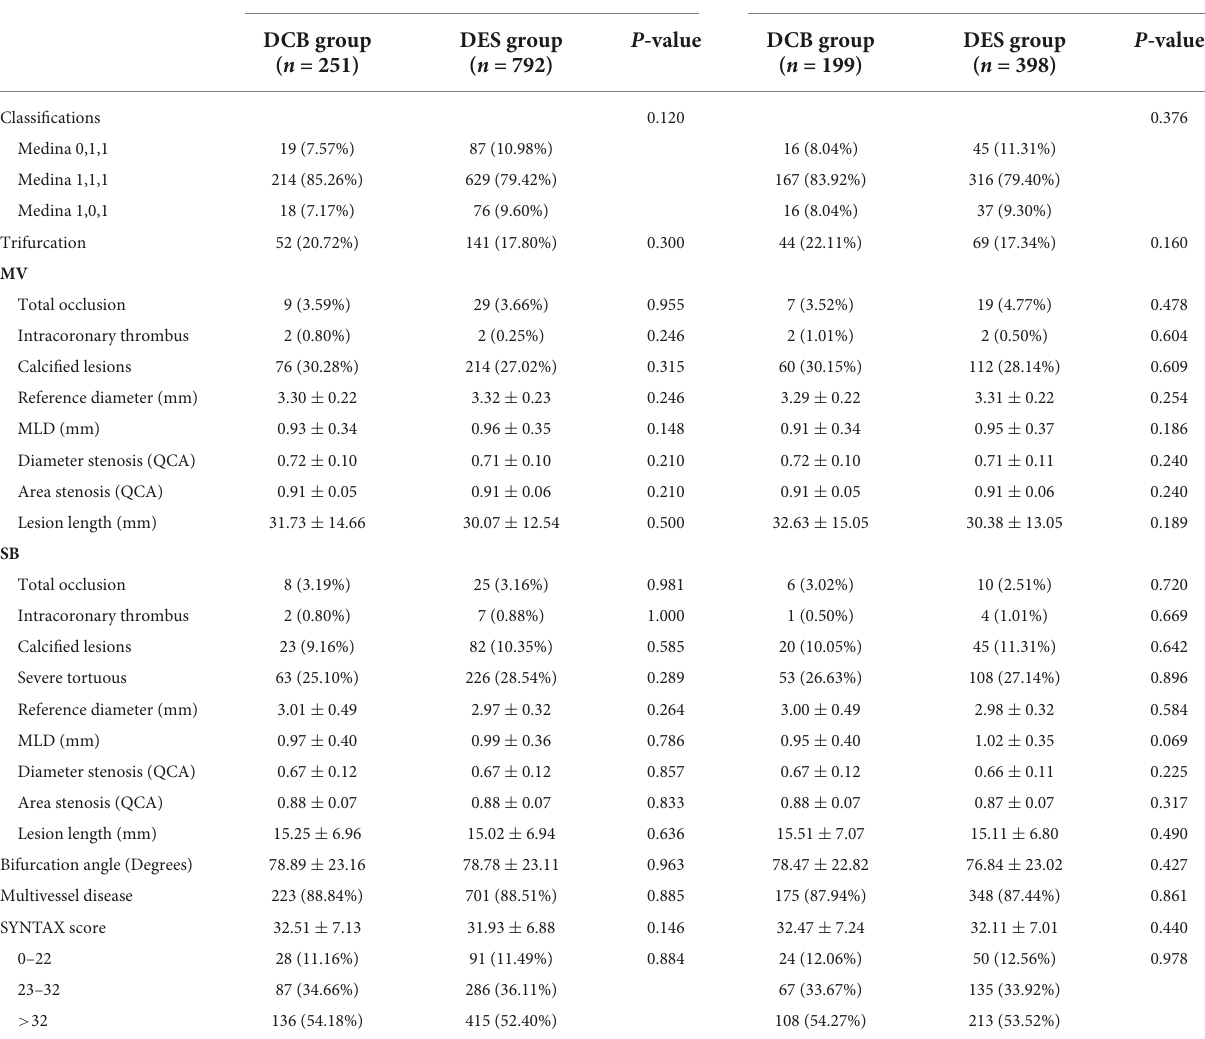
TABLE 2 Lesion characteristics before and after propensity-score